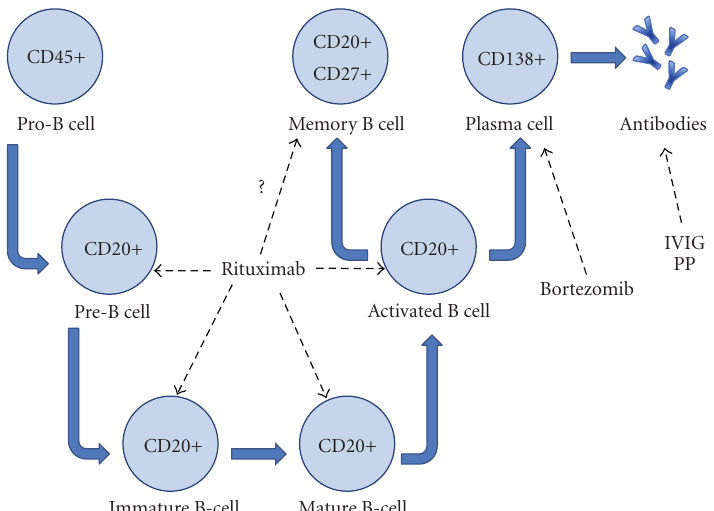
Figure 1: A simplified, conceptual diagram of the targets of current therapeutic modalities for pre-transplant desensitization and treatment of antibody mediated rejection. The dashed arrows indicate the sites of action for the therapeutics. Rituximab exerts its e ff ects on CD20+ B-cell lines with absence of activity against pro-B cells and plasma cells and questionable activity against memory B cells. Bortezomib targets plasma cells which elaborate the antibodies implicated in donor-specific antibodies and antibody-mediated rejection while the antibodies produced are targeted with intravenous immunoglobulin (IVIG) and plasmapheresis